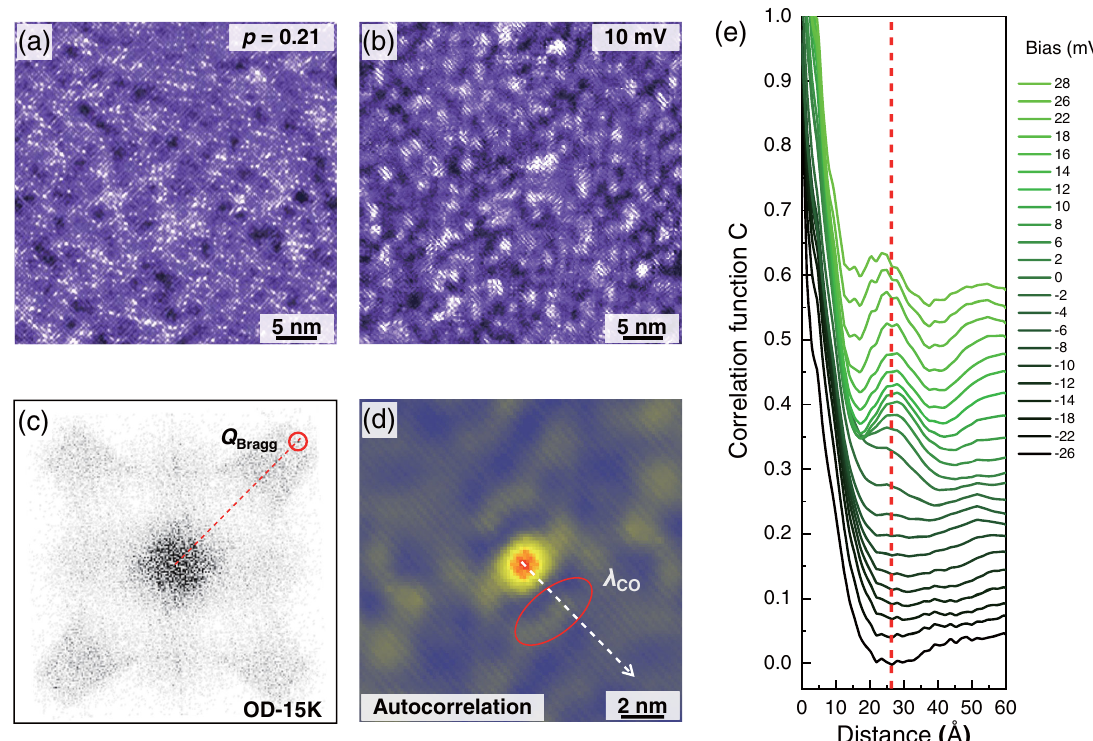
FIG. 3. The overdoped OD-15K sample with p ¼ 0 . 21 . (a) Atomically resolved topographic image acquired at V ¼ − 100 mV and I ¼ 20 pA over an area of 400 × 400 Å 2 . (b) The dI=dV map measured in the same area as (a) at bias voltage V ¼ 10 mV. (c) The Fourier transform map of (b). (d) The autocorrelation map of (b), where the bright arc marked by the red oval indicates the remnant charge order. (e) Bias-dependent autocorrelation intensity AC ð R Þ linecuts. The nondispersive first peaks suggest that the fussy arc corresponds to the glassy patterns of charge